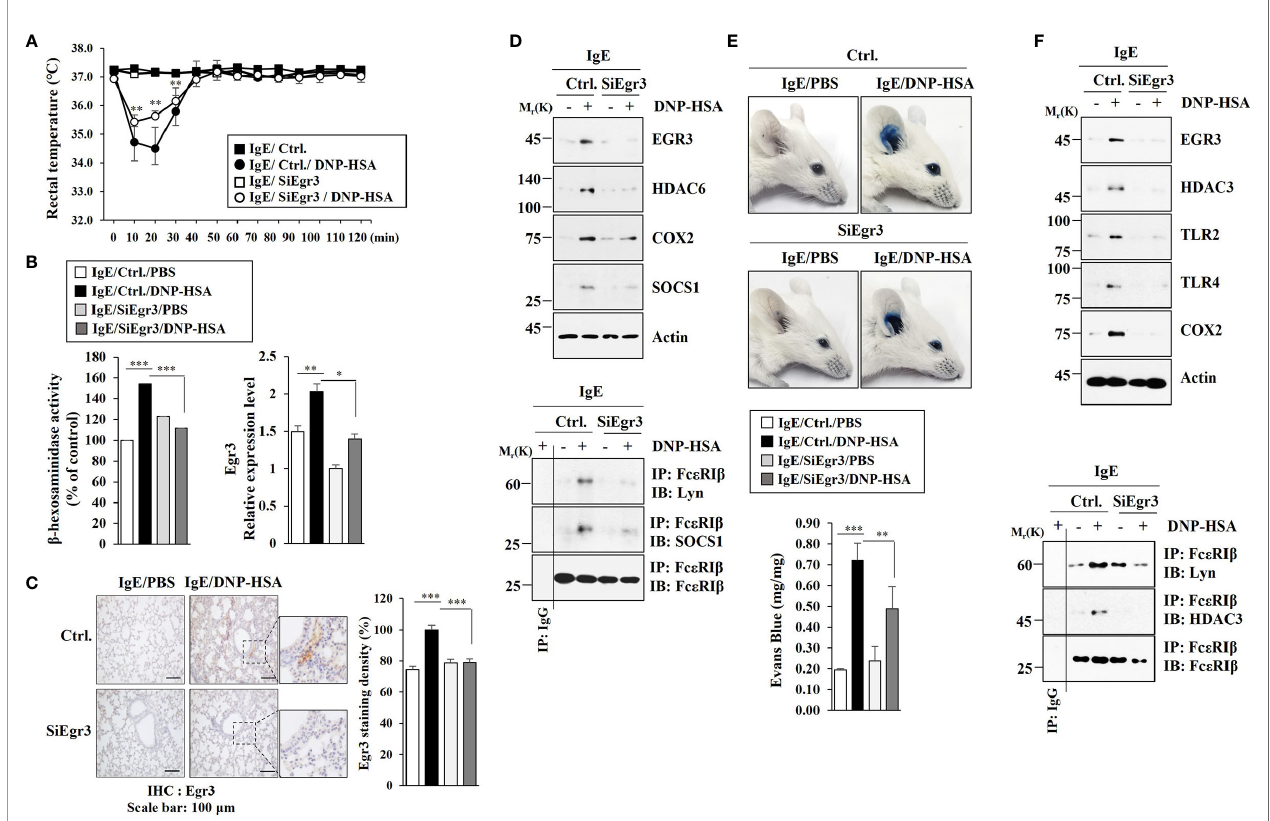
FIGURE 3 | Egr3 is necessary for anaphylaxis. (A) BALB/C mice were intravenously injected with the indicated siRNA (each at 3 m g/kg). The next day, BALB/C mice were given an intravenous injection of IgE (0.5 m g/kg). The following day, BALB/C mice were intravenously injected with DNP-HSA (250 m g/kg), and rectal temperatures were measured. Each experimental group comprised fi ve mice. The means ± S.E. of three independent experiments were shown. ** p <0.01, compared with IgE/Ctrl./DNP-HSA. (B) Lung tissue lysates were subjected to b -hexosaminidase activity assays and qRT-PCR. *, p<0.05; ** p <0.01; *** p <0.001. The data are expressed as mean ± SE of results from four mice of each experimental group. (C) Immunohistochemical staining employing lung tissues was performed. Representative images of the staining are shown (n=3). Quanti fi cation was performed by calculating the percentage of the staining intensities using Image J (NIH). *** p <0.001. (D) Immunoblot and immunoprecipitation employing lung tissue lysates were performed (n=4). Representative blots of three independent experiments are shown. (E) BALB/C mice were given an intradermal injection of IgE (0.5 m g/kg) and an intravenous injection of the indicated siRNA (each at 3 m g/kg). The next day, BALB/C mice were intravenously injected with PBS or DNP-HSA (250 m g/kg) along with 2% (v/v) Evans blue solution. Each experimental group comprised four BALB/C mice. ** p <0.01; *** p <0.001. (F) Immunoblot and immunoprecipitation employing ear tissue lysates were performed (n=4). Representative blots of three independent experiments are